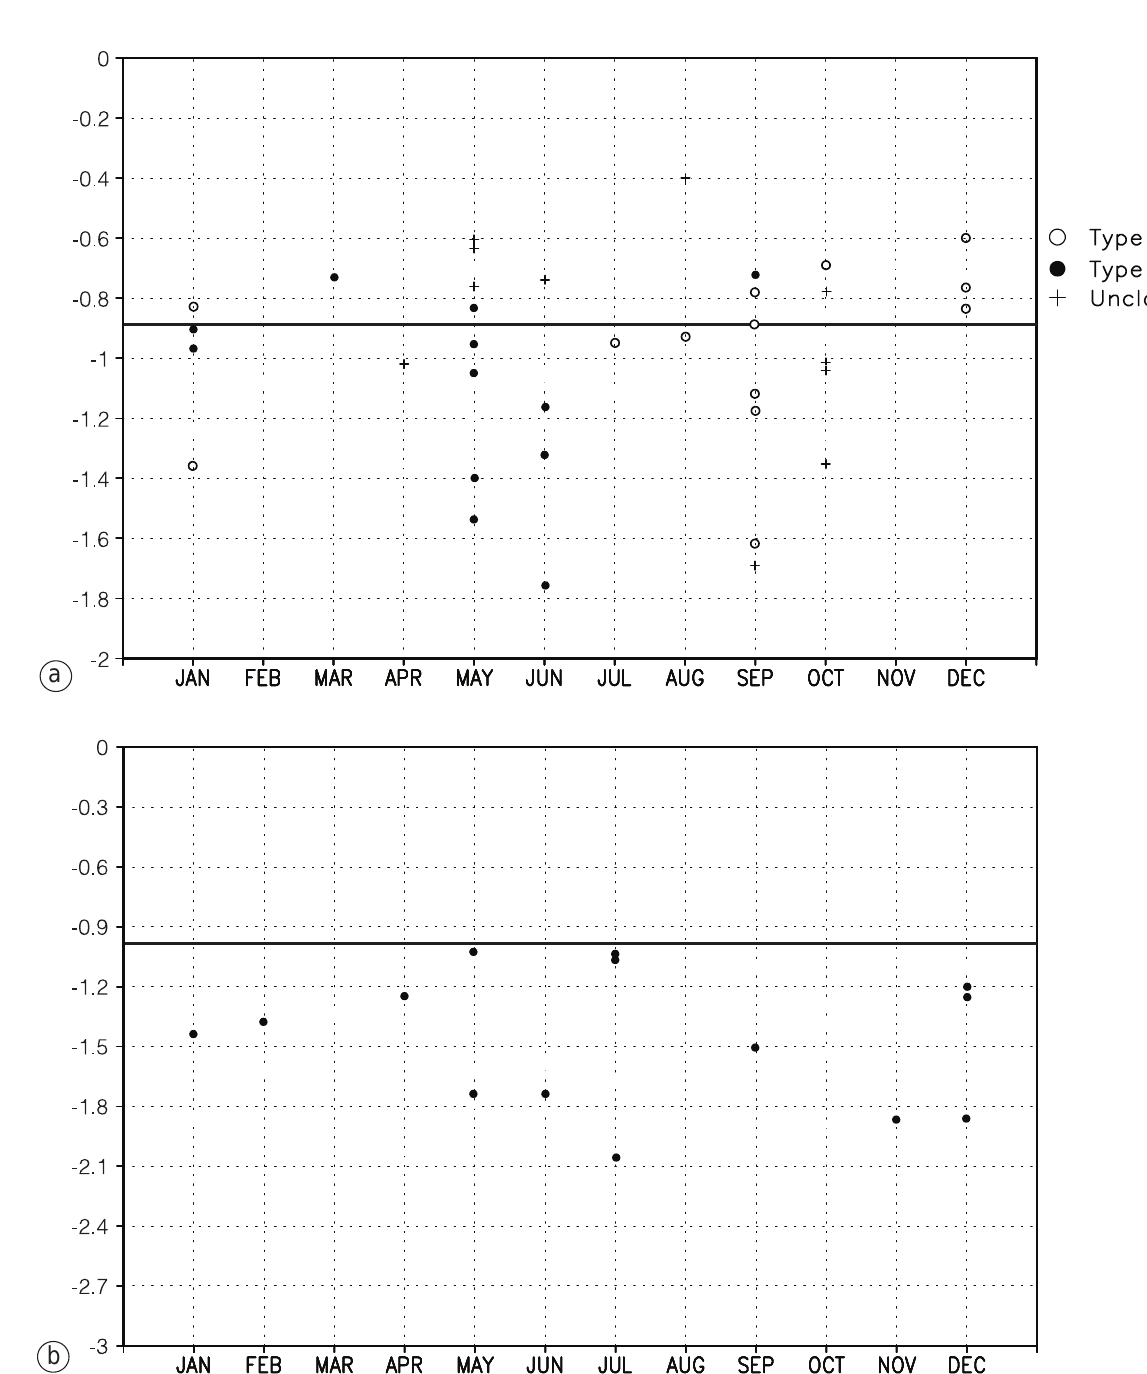
Fig. 7a,b. a) Seasonal distribution of cold SST anomaly peaks in the SINTEX simulation. The horizontal line marks the 1.5 standard deviation threshold for the Niño3 Index; b) as in (a), but for the observed SST anomalies (COADS + IGOSS, 1950-1999)